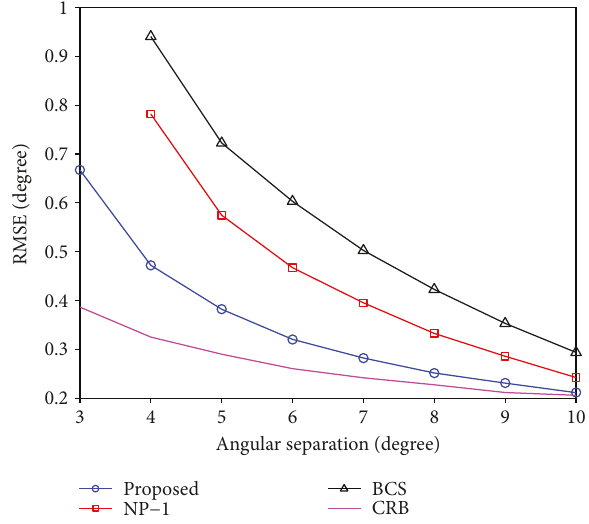
Figure 7: RMSE versus SNR with the fi xed number of snapshots 200.